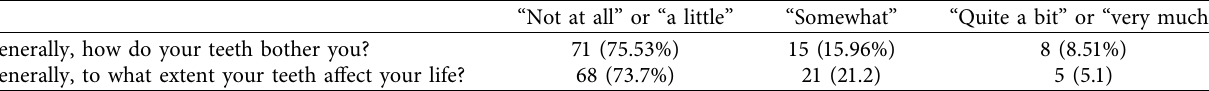
Table 2: Responses of the Moroccan participants ( n � 94) to the two global questions. “Not at all” or “a little” “Quite a bit” or “very much”